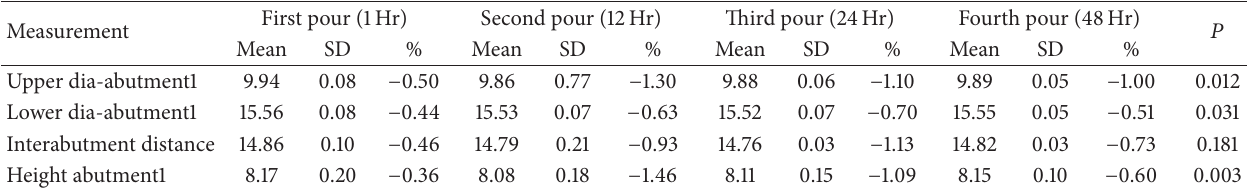
Table 4: The mean measurement values of stone dies, standard errors, and percentage of errors from master cast from polyether impression